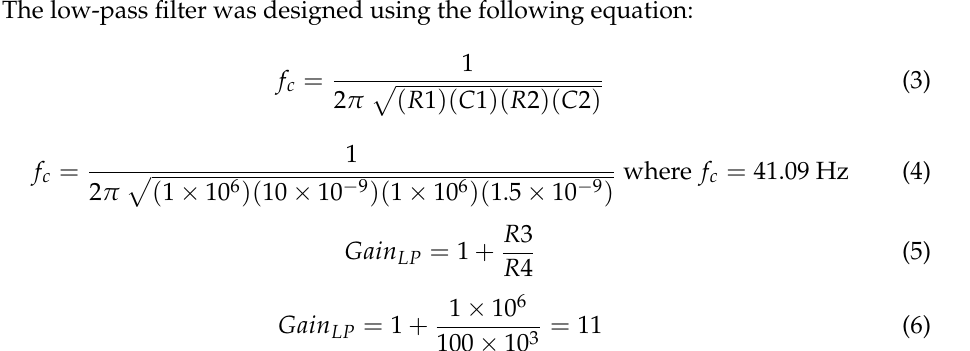
Table 6. Electronic components BOM.